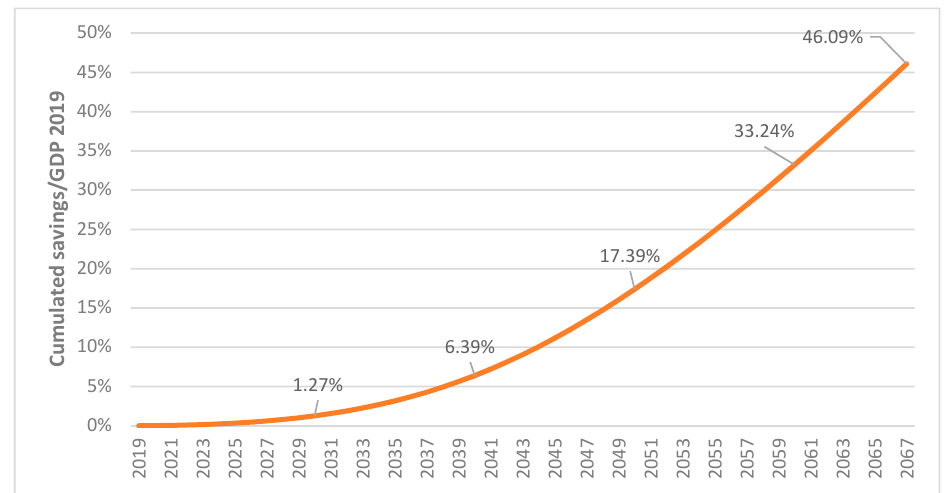
Figure 6. Annual savings/GDP applying the SF. BDE and Authors. Source: Hernandez de Cos (2020) and prepared by author.